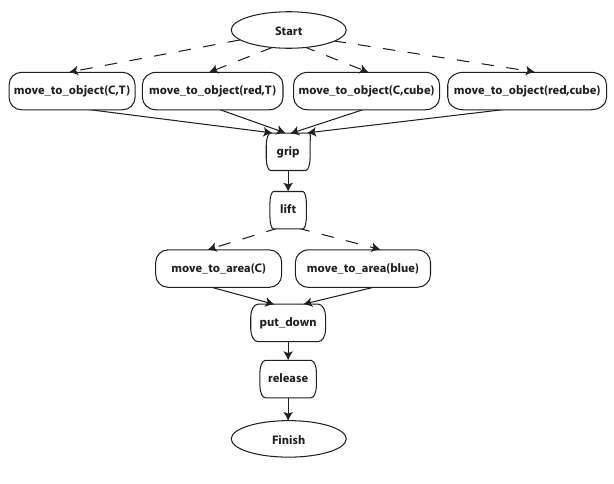
Figure 7. A schematic of the demonstrated sequence going vertically from top to bottom, where each square represents the execution of a prim- itive. Alternative interpretations of the demonstrated sequence are drawn horizontally, with the most general interpretation to the left and the most specific to the right. C and T are unspecified attributes representing all, or a subset of, possible values for color and type, respectively. Dashed lines mark ambiguous steps in the sequence, that require further